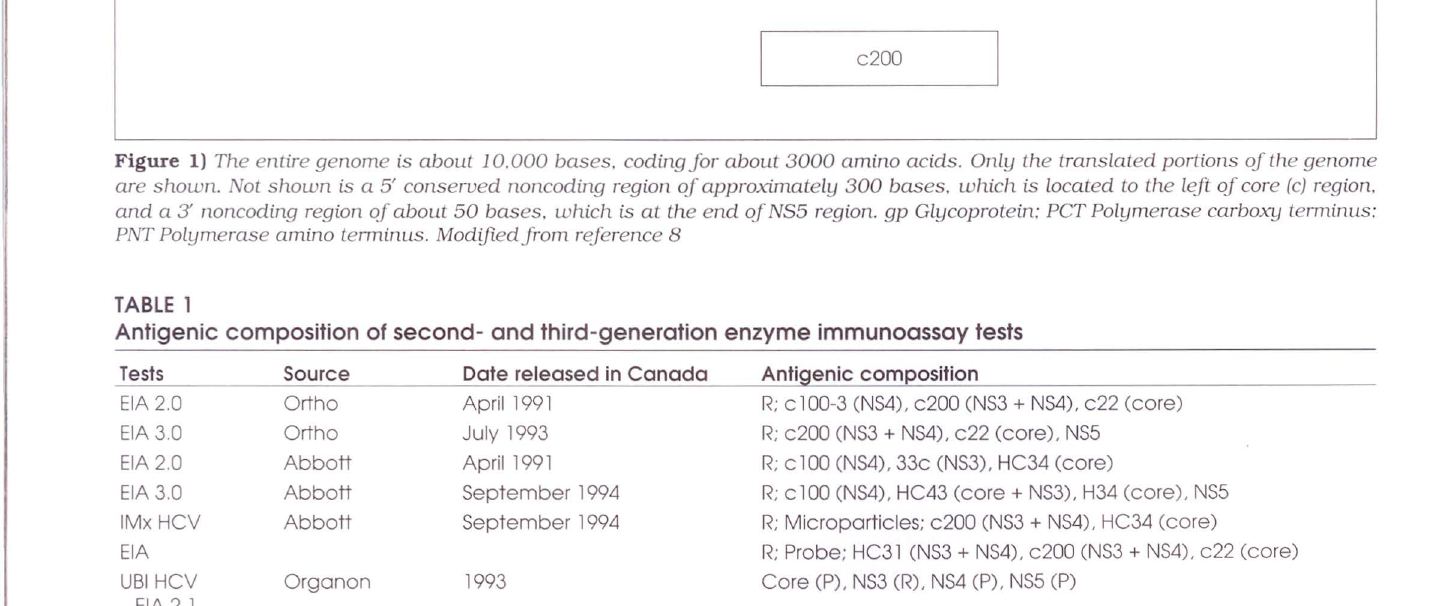
Antigenic composition of second- and third-generation enzyme immunoassay